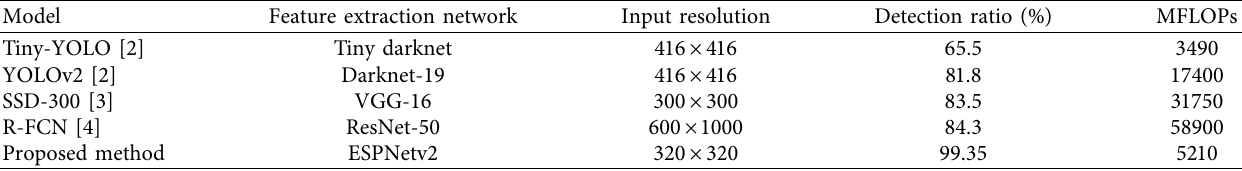
Table 4: Detection results on the RP subset of AOLP